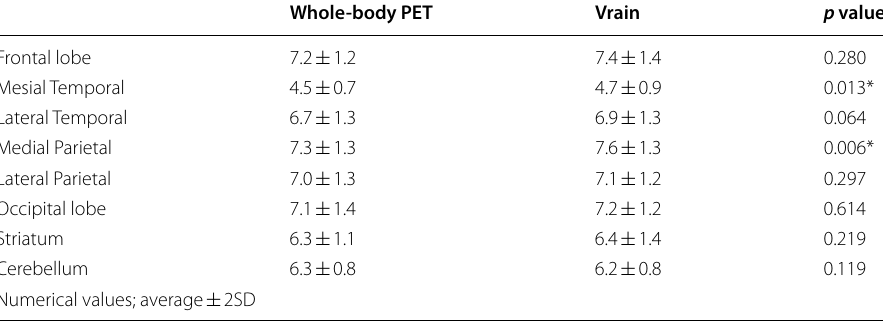
SUVs are presented as the average